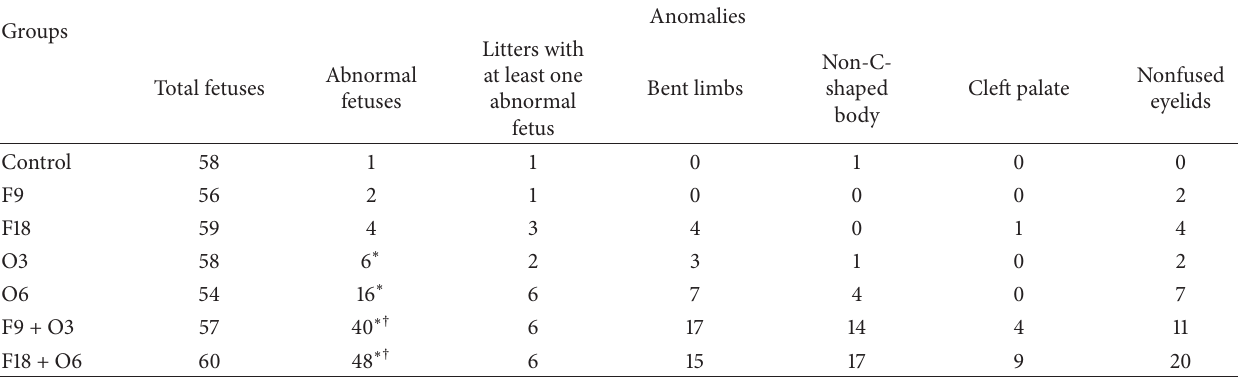
Table 1: The number of total and abnormal fetuses and litters in the different groups (F: fluoxetine with doses of 9 and 18mg/kg and O: olanzapine with doses of 3 and